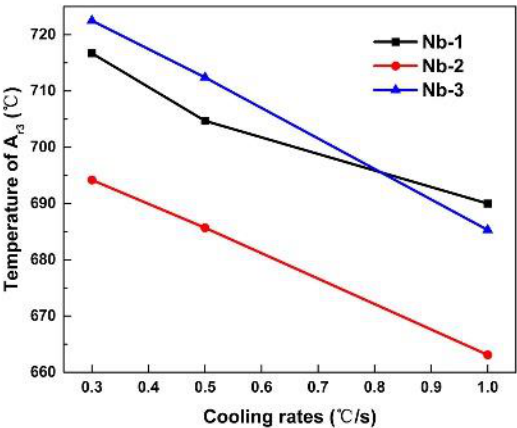
Figure 6. Dependence of A r3 on cooling rate of the tested steels.